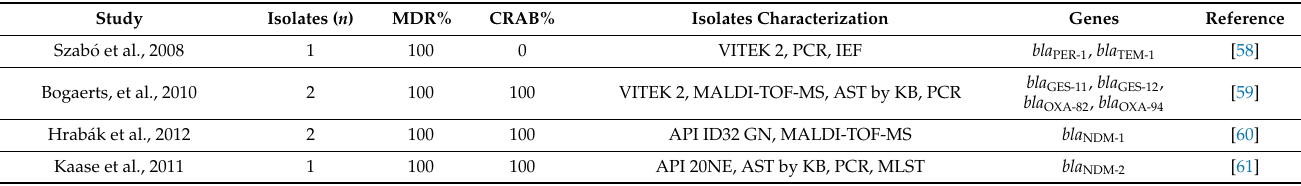
Table 2. A. baumannii in